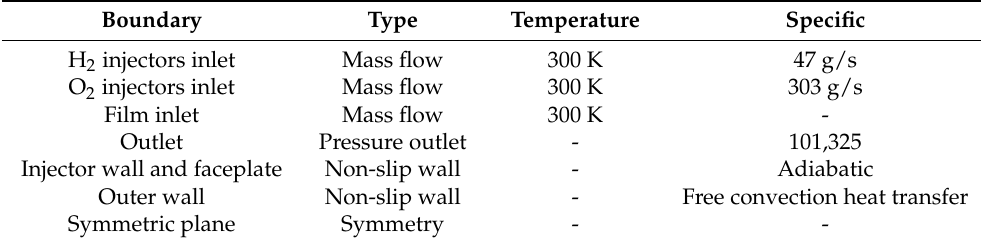
Table 3. Numerical setup boundary